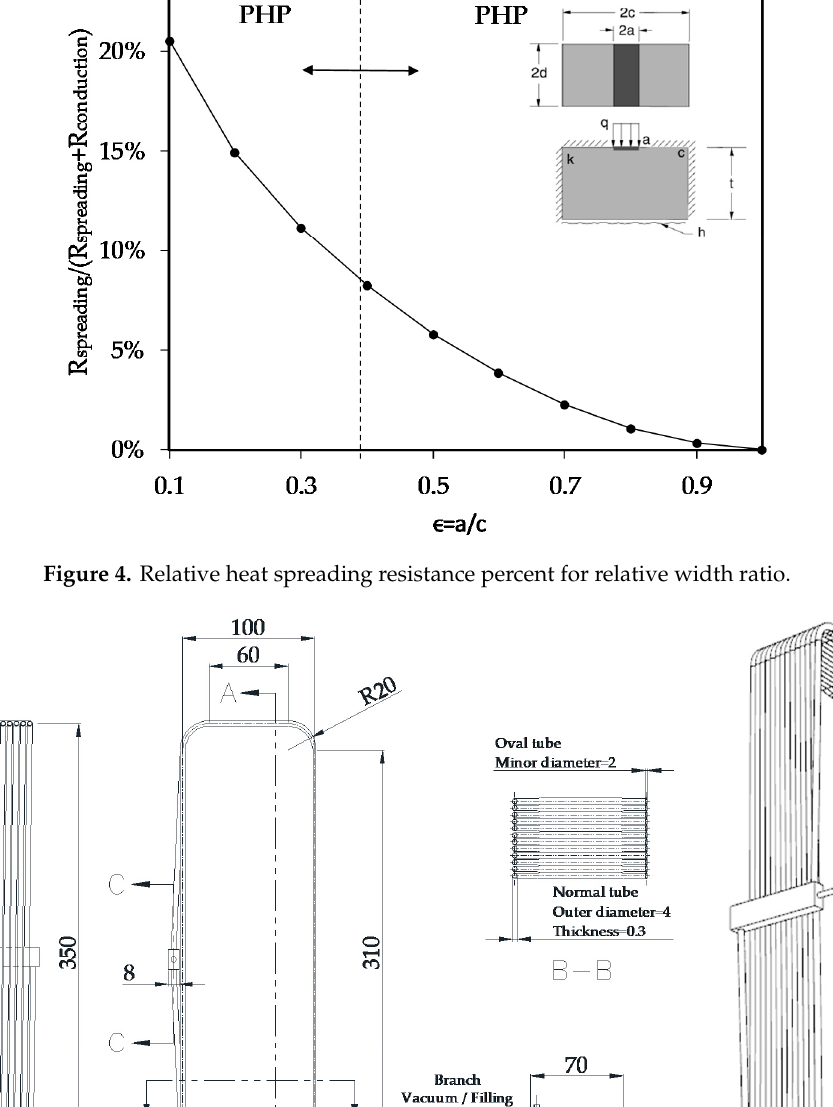
Figure 5. Schematic of the present pulsating heat pipe (Unit: mm).